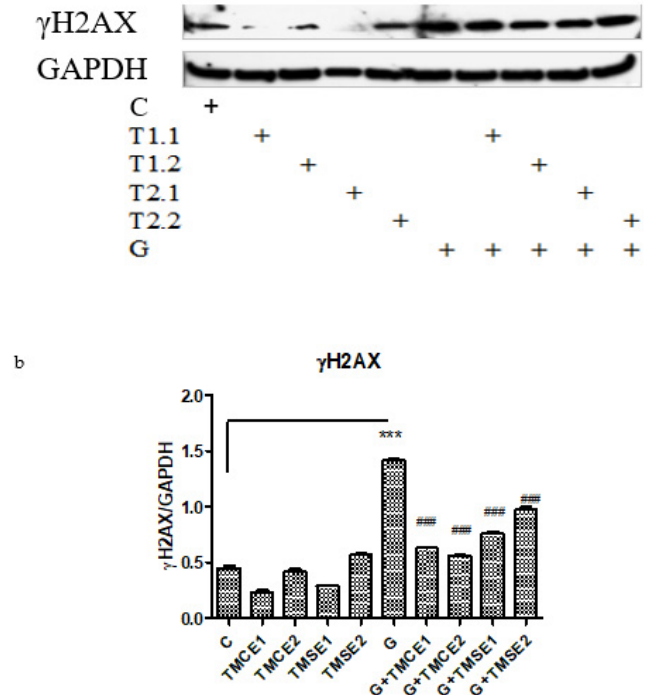
Figure 5. HIF-1 α and γ -H 2 AX expressions in HUVECs after exposure to hyperglycemia and normo- glycemia and after treatment with T. marschallianus extracts. Image analysis of WB bands was done by densitometry in upper panels ( a ) and results were normalized to GAPDH in lower panels ( b ). The exposure to hyperglycemic medium induced DNA lesions while the two extracts exerted the protection on DNA damage. The statistical significance between the treated cells and control group was assessed with two-way ANOVA followed by the Bonferroni post-hoc test. Each bar represents mean ± standard deviation (n = 3); *** p < 0.001 vs. control (untreated cells); ### p < 0.001 vs. cells exposed to hyperglycemia.